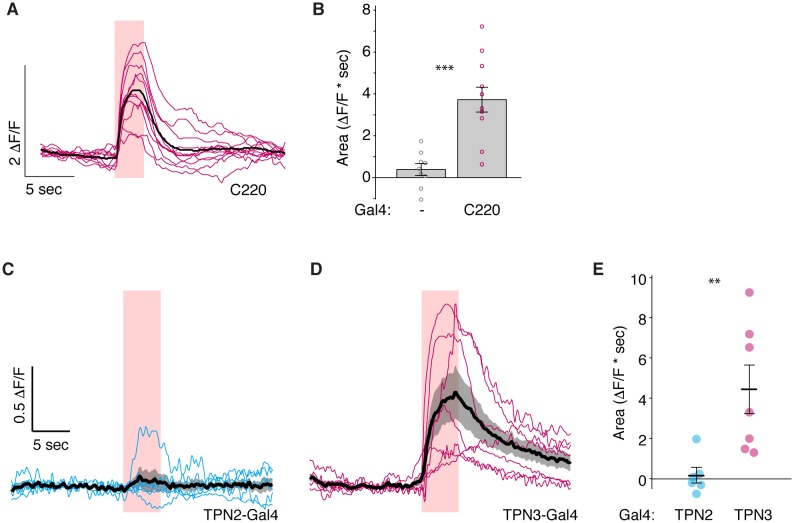
Controls for PPL1 imaging experiments.(A–B) Imaging calcium responses of PPL1-MV neurons to CsChrimson activation of second TPN3 Gal4 line (C220) shows qualitatively similar results to first Gal4 line (Figure 8B and D). n = 9–11. Error bars indicate mean ± SEM. Wilcoxon rank-sum: ***p<0.001. (C) Ex vivo calcium imaging of PPL1-MV1 neurons to CsChrimson activation of TPN2. PPL1-MV response across multiple animals (thin blue lines) shown with mean (thick black line) and standard deviation (gray area). (D) Ex vivo calcium imaging of PPL1-MV1 neurons to CsChrimson activation of TPN3. PPL1-MV response across multiple animals (thin pink lines) shown with mean (thick black line) and standard deviation (gray area). (E) Average area under the curve. TPN2 activation does not show reliable increase or decrease in PPL1-MV calcium signal (unlike in the in vivo experiments – Figure 8C,D). TPN3 activation shows reliable PPL1-MV1 activation (though smaller in magnitude compared to in vivo experiments). n = 6–7. Error bars indicate mean +/-± SEM. Wilcoxon rank-sum: **p<0.01.